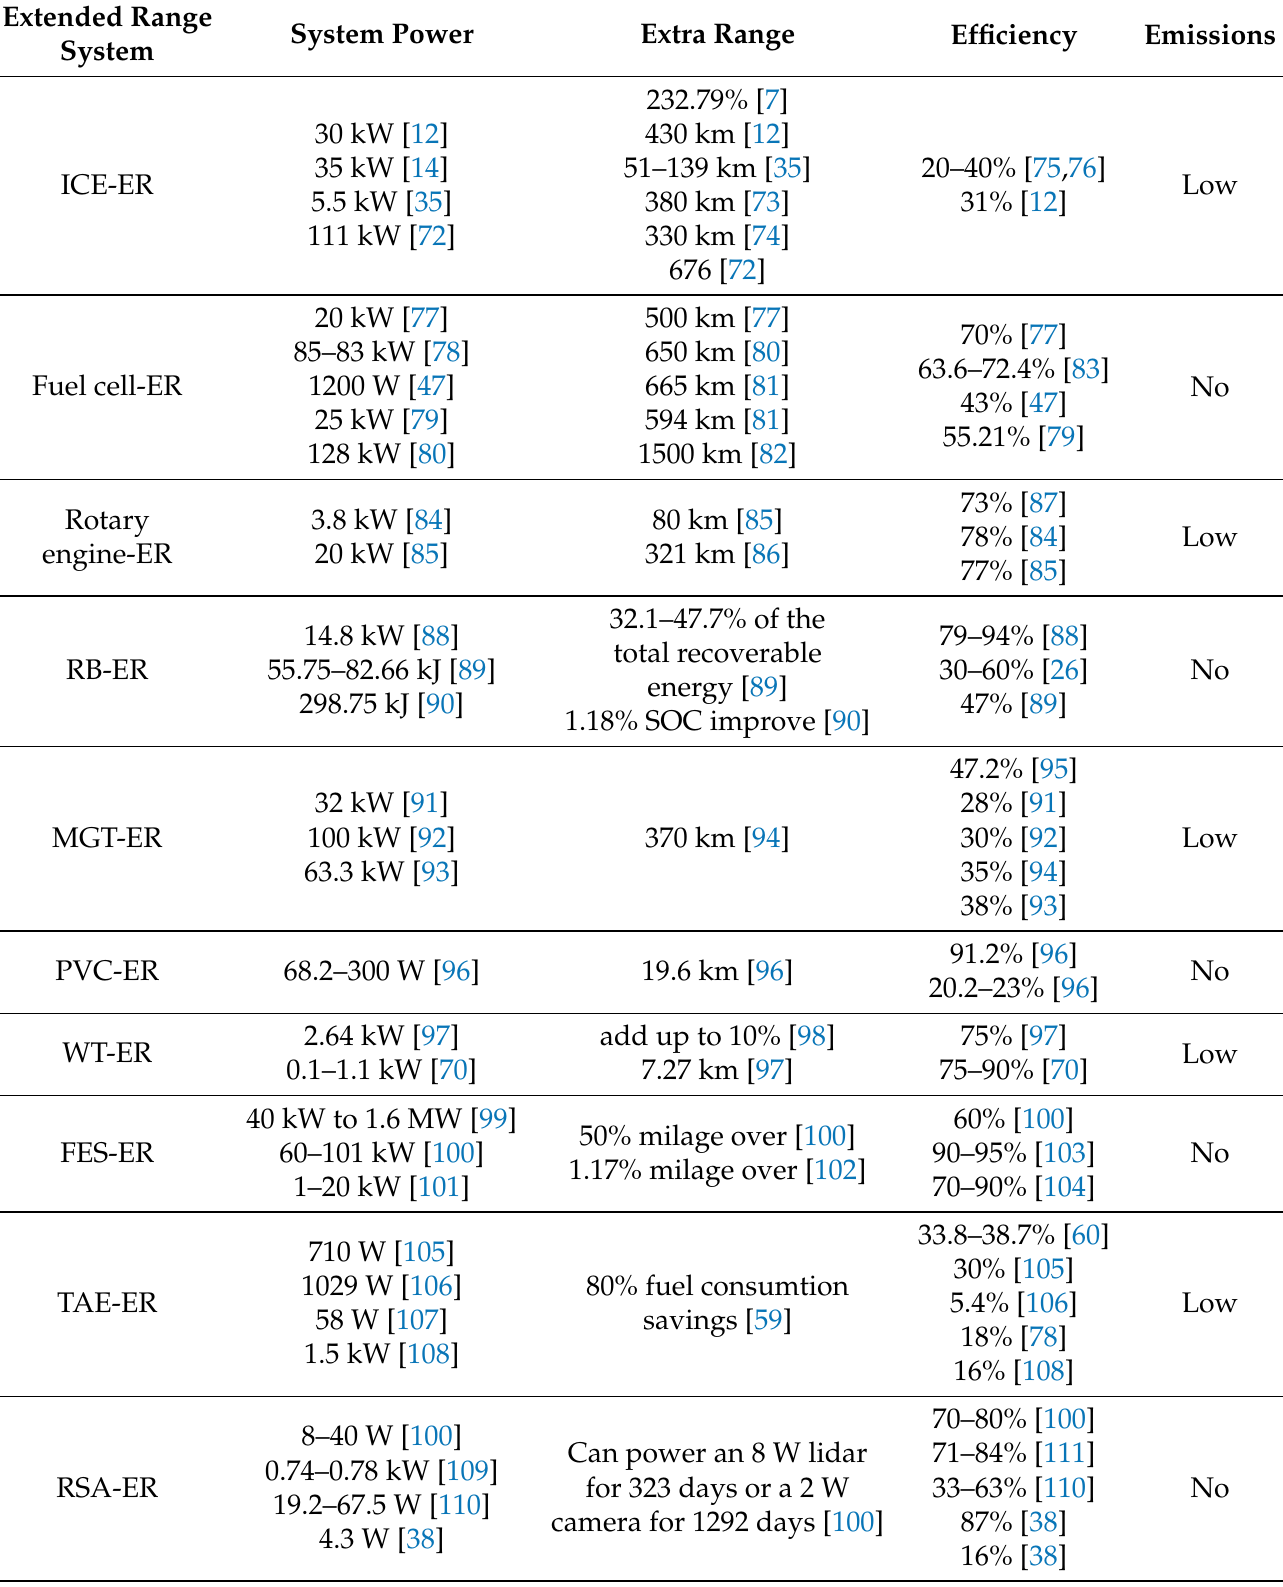
Table 1. A comparison of the extended range